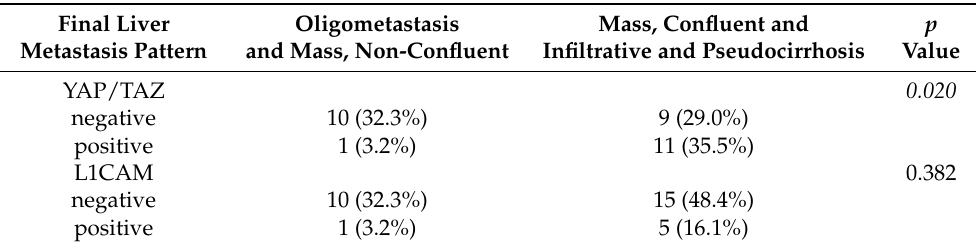
Table 4. Association between immunohistochemical stain of YAP/TAZ and L1CAM with final liver metastasis